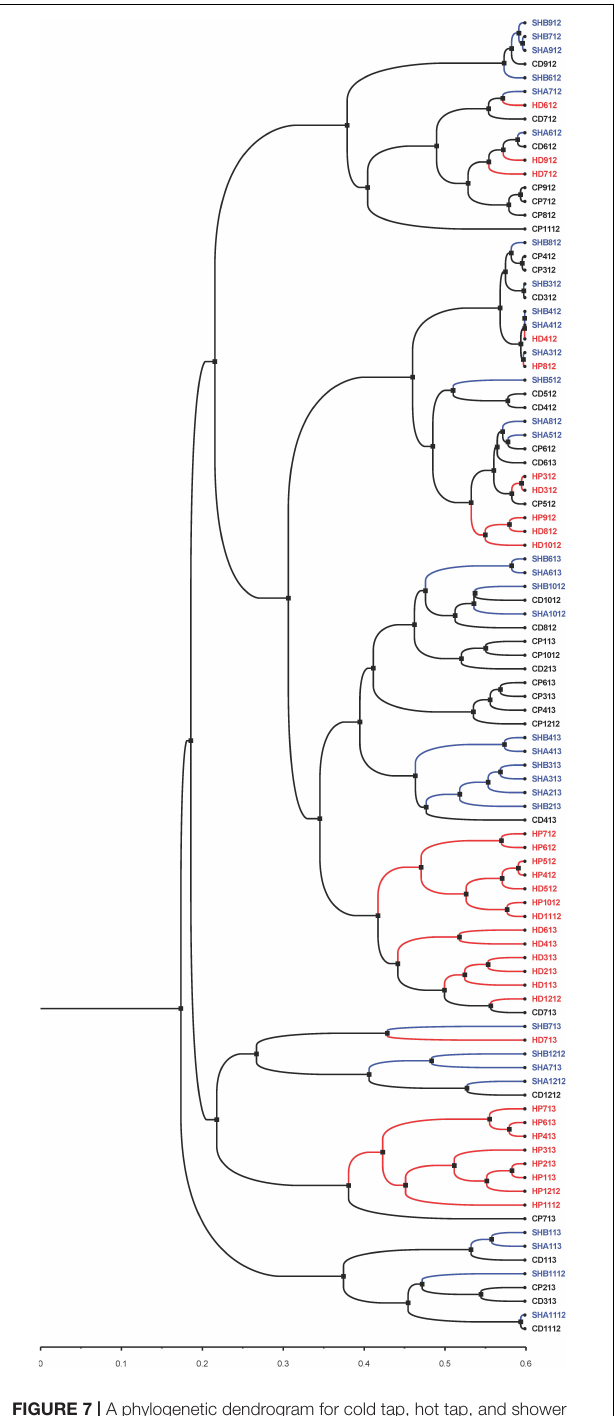
FIGURE 7 | A phylogenetic dendrogram for cold tap, hot tap, and shower water. Visualized with FigTree (version 1.4.4). Letters in the sample IDs: CP : Cold tap water-First draw. CD : Cold tap water-Second draw. HP : Hot tap water-First draw. HD : Hot tap water-Second draw. SHA : Shower water-First draw. SHB : Shower water-Second draw. Numbers in the sample IDs: Sampling dates in the format of “MYY” or “MMYY,” where the “M” or “MM” stands for month and the “YY” stands for the year (2012 and 2013). For instance, the sample ID of “SHB1112” stands for the second draw of shower water sampled in November